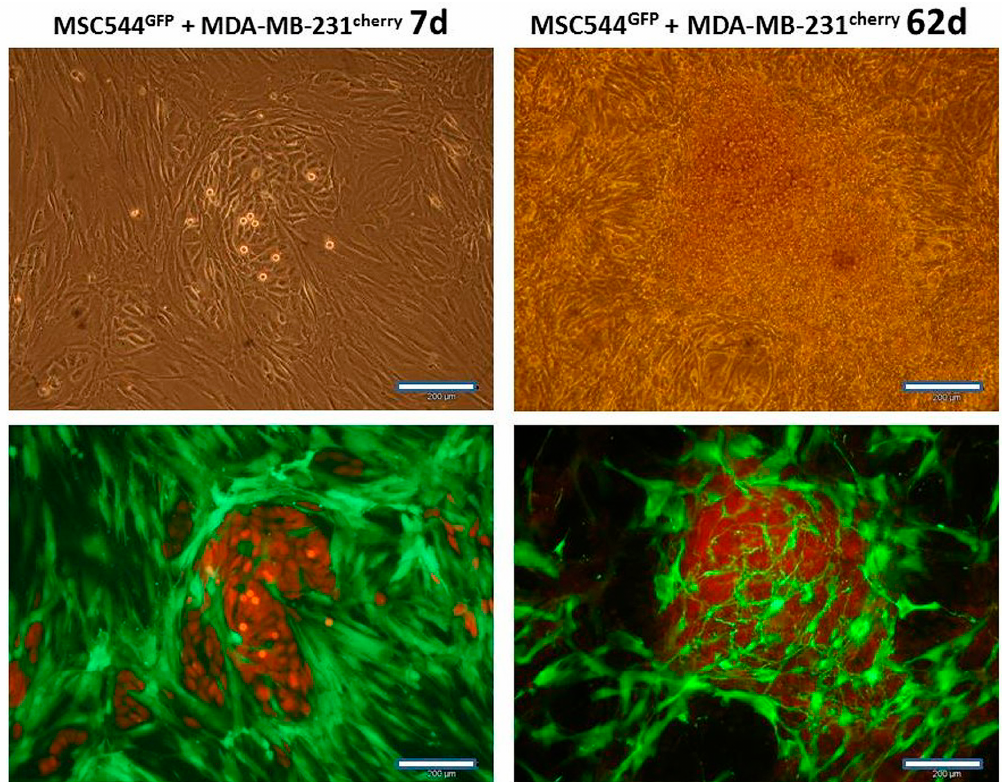
Figure 2. Long-term co-culture of human MSC544 GFP with MDA-MB-231 cherry breast cancer cells. Phase contrast (upper panel) microscopy, double fluorescence (red + green) microscopy (lower panel, left micrograph), and only green fluorescence microscopy (lower panel, right micrograph) was performed in co-cultures of MSC544 GFP with MDA-MB-231 cherry breast cancer cells for 7d and 62d, respectively. The highly proliferating and overgrowing breast cancer cells were forming three-dimensional (3D) spheroids together with MSC after 62d whereby the bright cherry fluorescence was partially detectable in the green fluorescence channel (lower panel, right micrograph). Scale bars: 200µm.